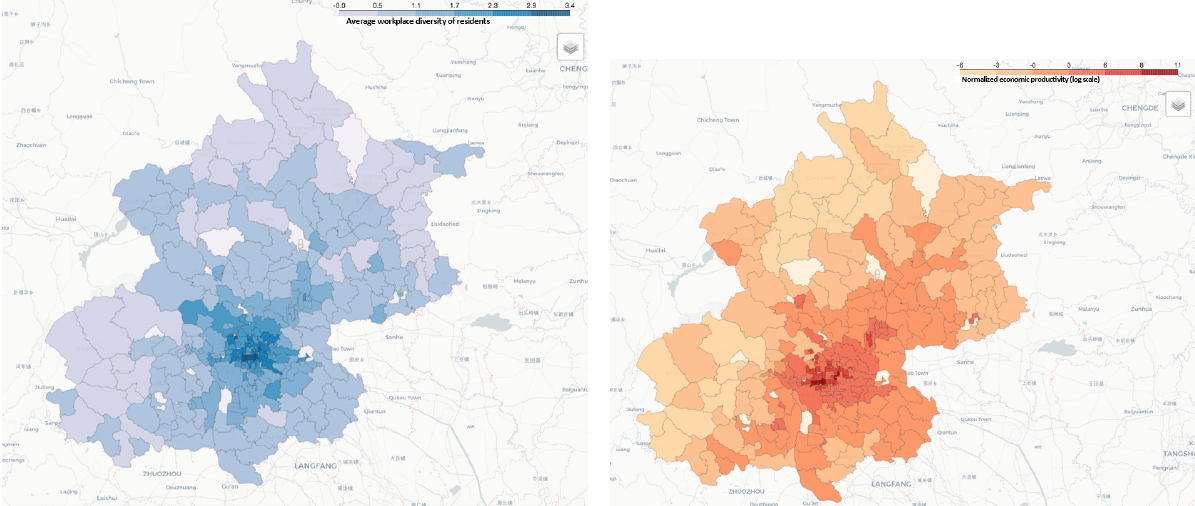
Fig. 5 Social bridges diversity (i.e., diversity of physical interactions between neighborhoods) (left) and year-on-year economic growth for neighborhoods within the city of Beijing (right). The diversity of social bridges predicts up to 50% of the variance in year-on-year economic growth for Beijing as well as US and EU cites [28]